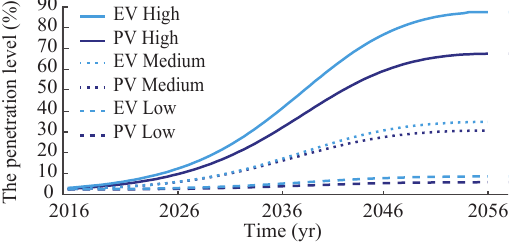
Figure 14. The penetration levels of EV and PV in the next 50